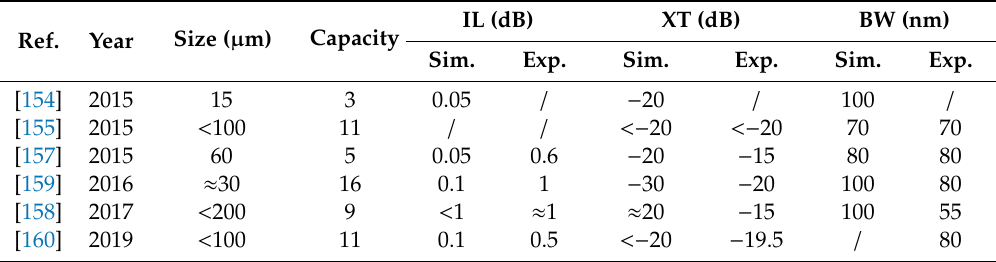
Table 4. Summary of the reported DPWA-based